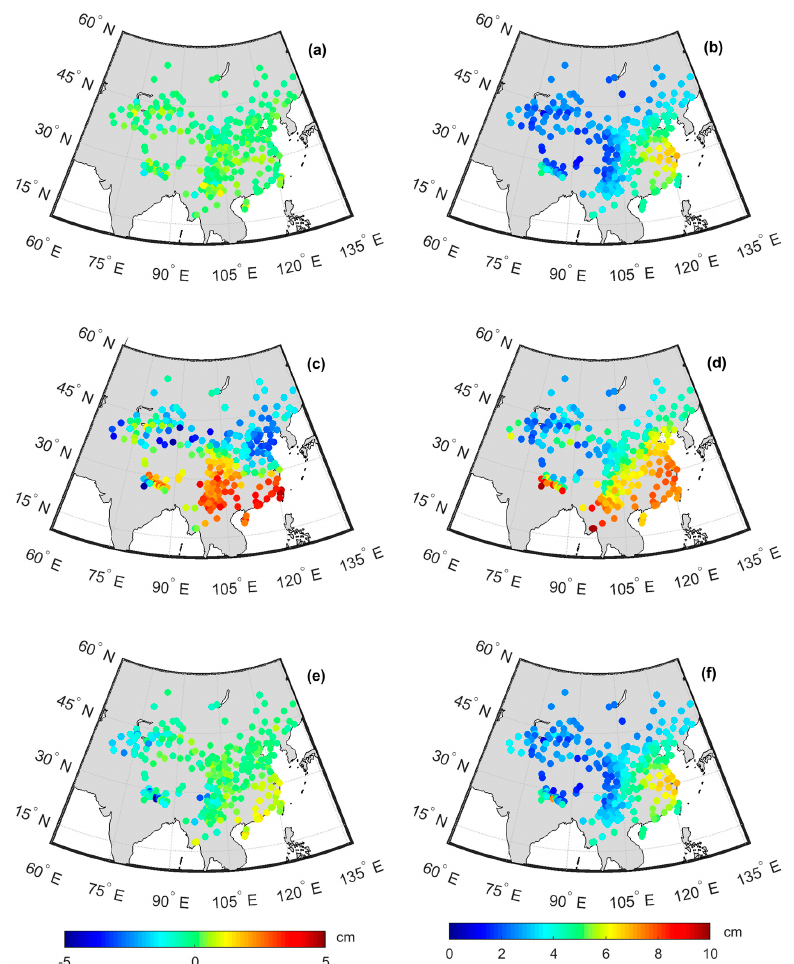
Figure 7. Comparisons between RAW ZTD and empirical models during the period of 2012–2018. Left: mean value of ZTD biases for ( a ) SHAtropE, ( c ) UNB3m, and ( e ) GPT3; Right: RMS values of the ZTD biases for ( b ) SHAtropE, ( d ) UNB3m, and ( f ) GPT3. Remote Sens. 2020 , 12 , x FOR PEER REVIEW